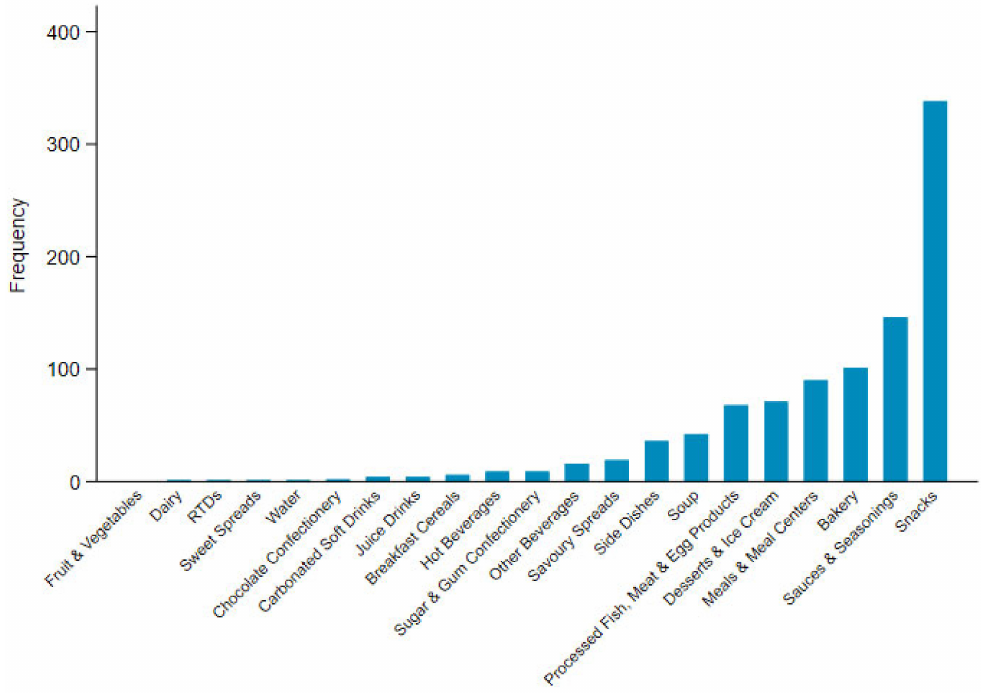
Figure 5. Frequency of discretionary products scoring a Health Star Rating ≥ 2.5 by Mintel